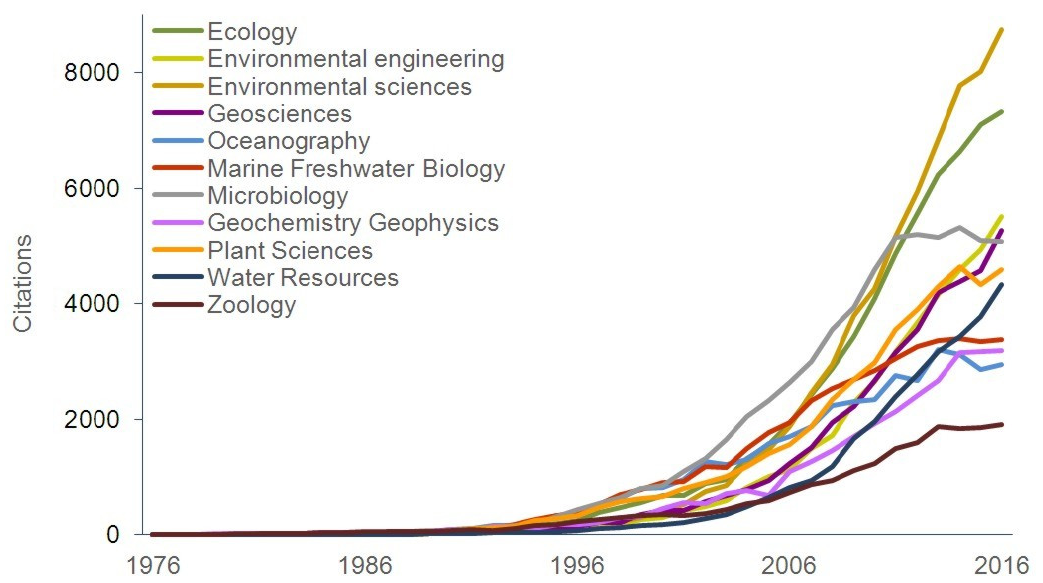
Figure 8. Citations of publications involving researchers based in Catalan institutes and centers. They are grouped by fields related to environmental research according to the Web of Science database. The English names have been used to avoid translation ambiguities. Source: Prepared by the authors.